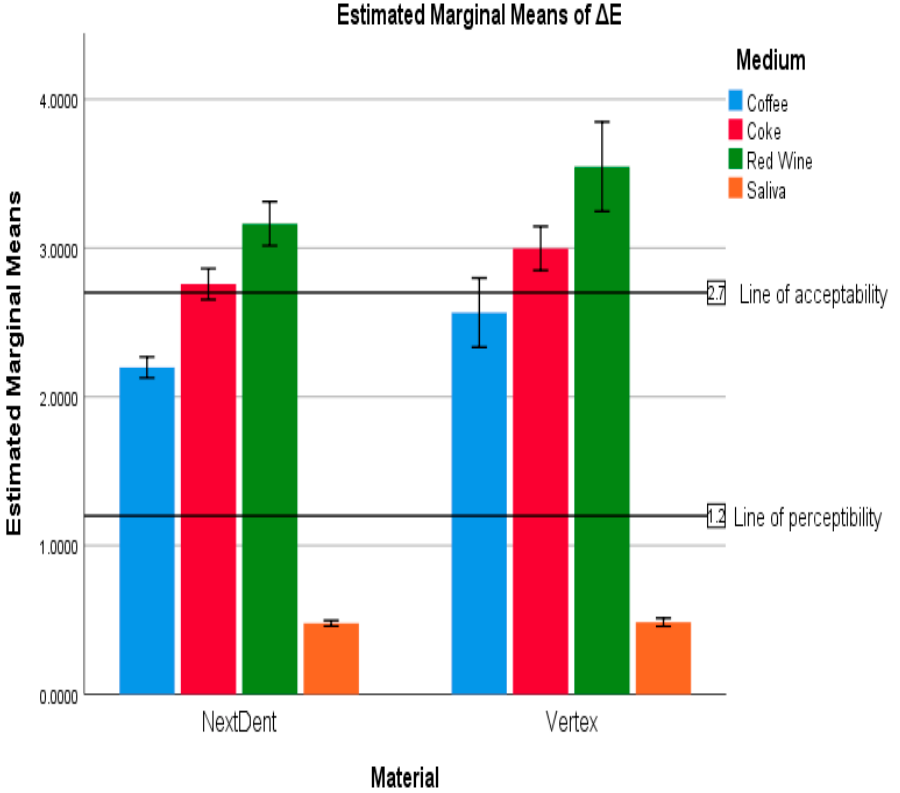
Figure 4. Interactive plot for mean colour difference—interaction between type of material and staining medium, with thresholds of acceptability/perceptibility.